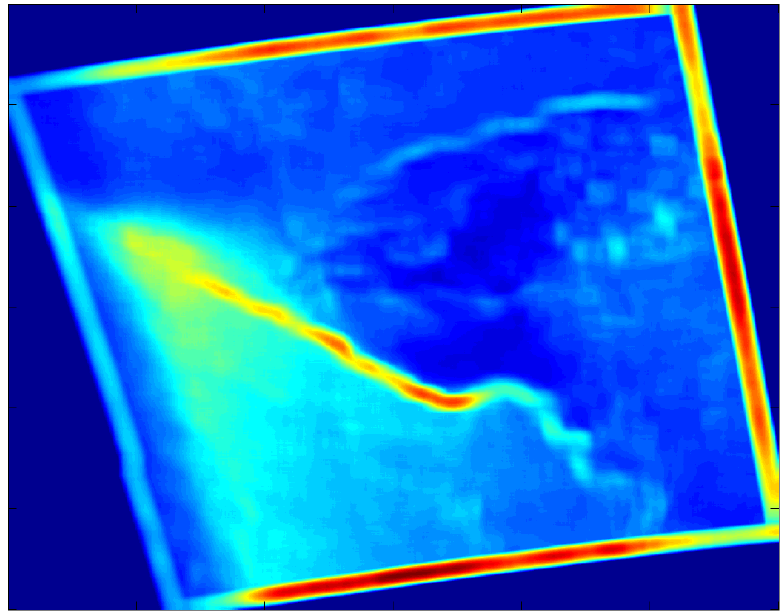
Figure 7. Local standard deviation filtered SDWS image for the case study, 0533 UTC on December 9, 2007. The two meandering bright blue to red bands indicate the fronts. The seclusion appears as dark blue speckled with the cyan rectangles corresponding to the mesoscale convective